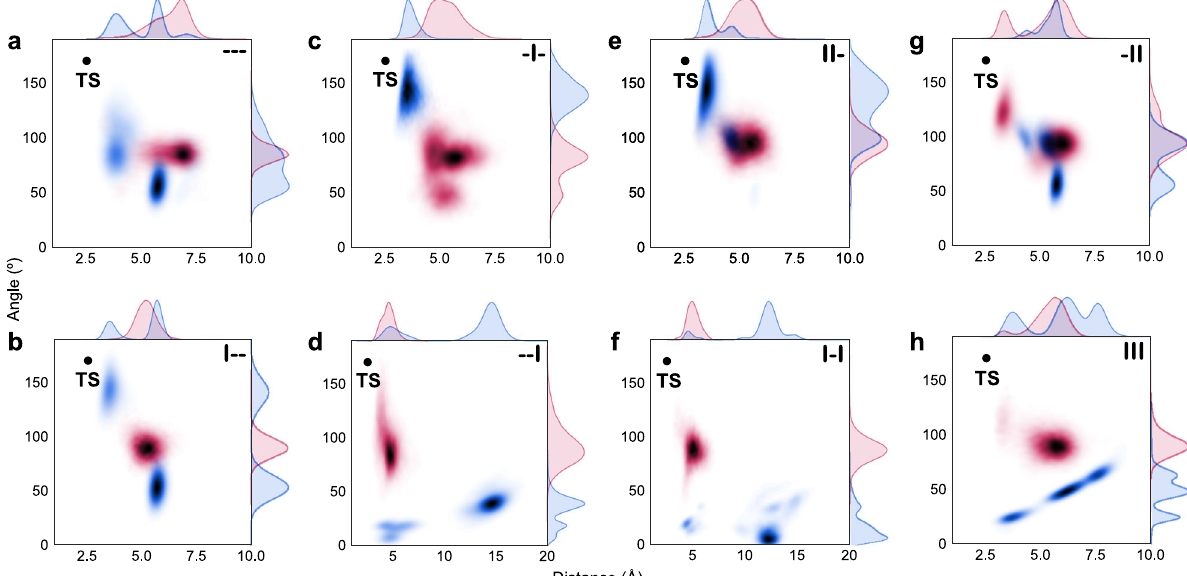
Fig. 3 Conformational population analysis of key geometric parameters for hydroxylation. Distances determined between the oxygen atom of haem- Fe = O and the C-atom (C2 or C15) of 1 ( x -axis) and angles formed by O(Fe = O) – ( 1 )-H(C2/15) – ( 1 )-C(2/15) ( y -axis) from the fi rst replica of the MD dataset of parent mutant ( a ), “ single ” mutants ( b – d ), “ double ” mutants ( e – g ) and “ triple ” mutant III ( h ) (see Supplementary Figs. 6 and 7 for additional replicas). Geometric parameters measured for C-2 and C-15 are shown in red and blue, respectively. The ideal distance and angle for the transition state TS (black dot) corresponds to the Density Functional Theory (DFT) optimized geometry for the C – H abstraction by haem-Fe = O using a truncated computational model (Supplementary Note 2). See Fig. 1d for mutant